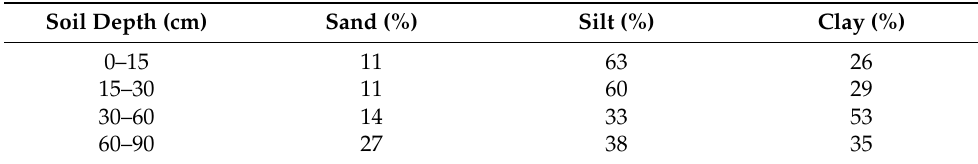
Table 2. The soil texture of the initial soil in the experimental field.